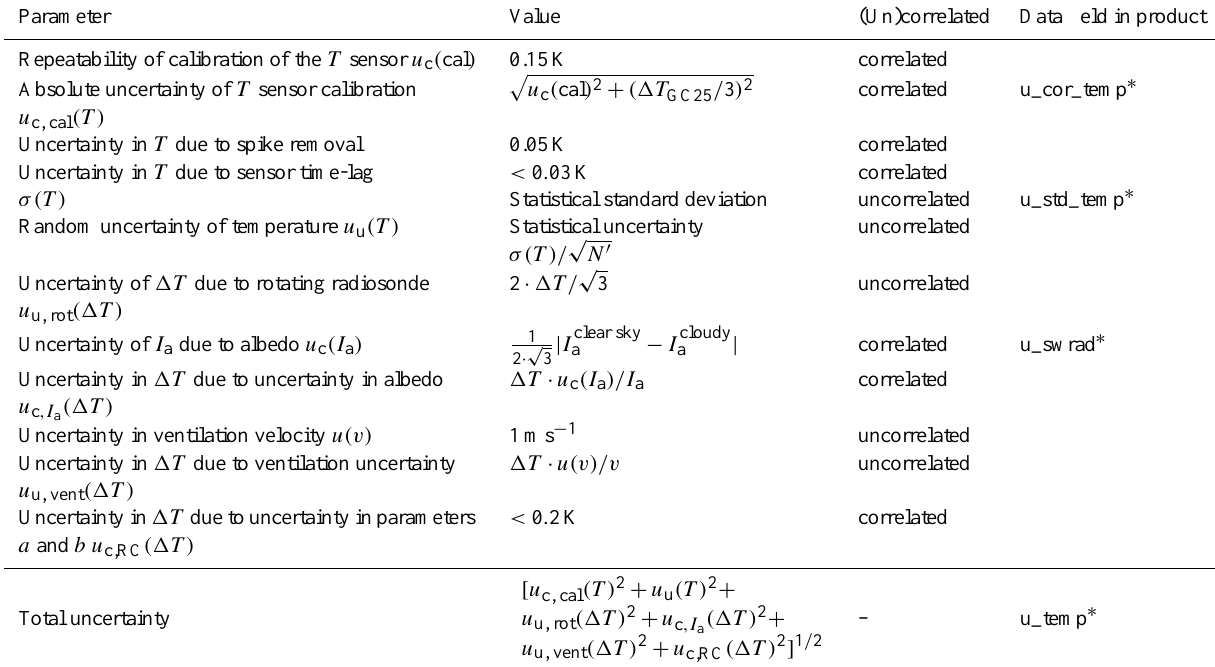
Table 2. Overview of the sources contributing to the temperature uncertainty budget; values are given for 2 σ ( k = 2). The items involving (cid:49)T relate to the radiation temperature correction.